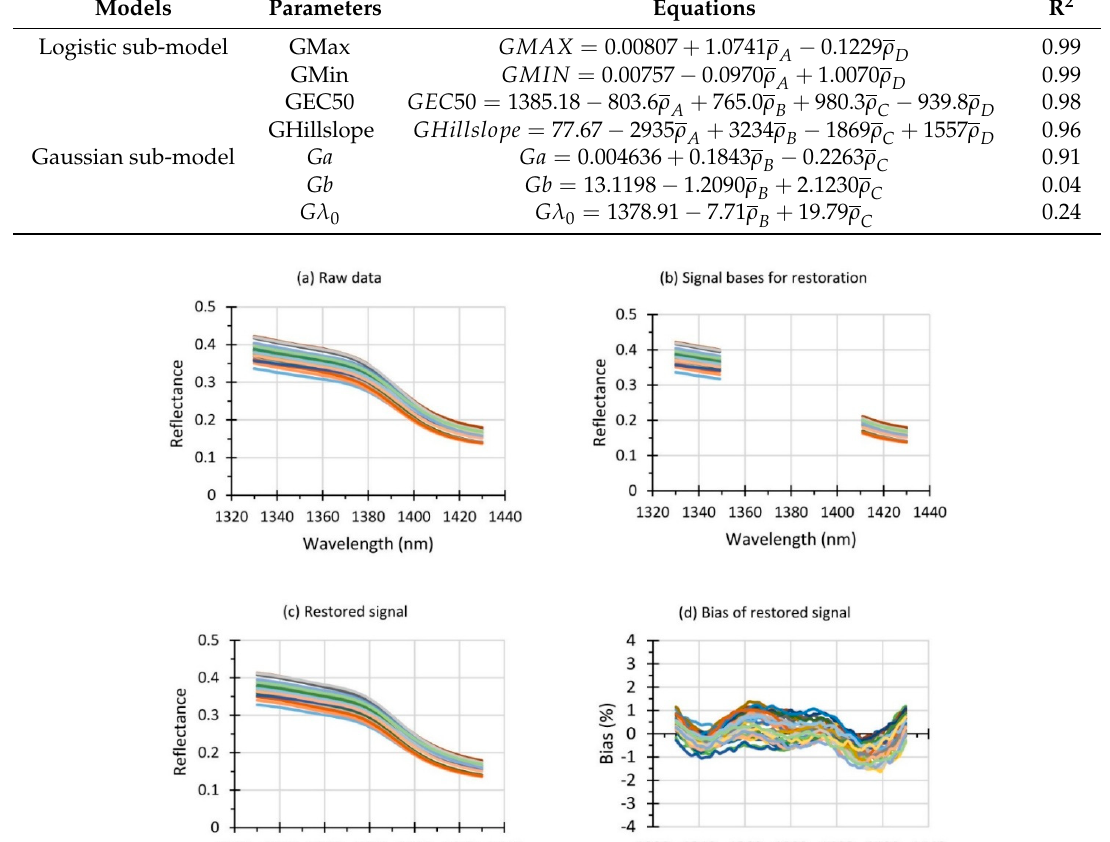
Table 1. Summary of the laboratory based data for generalized Logistic-Gaussian complex signal model (GLGCM) logistic and Gaussian sub-models.